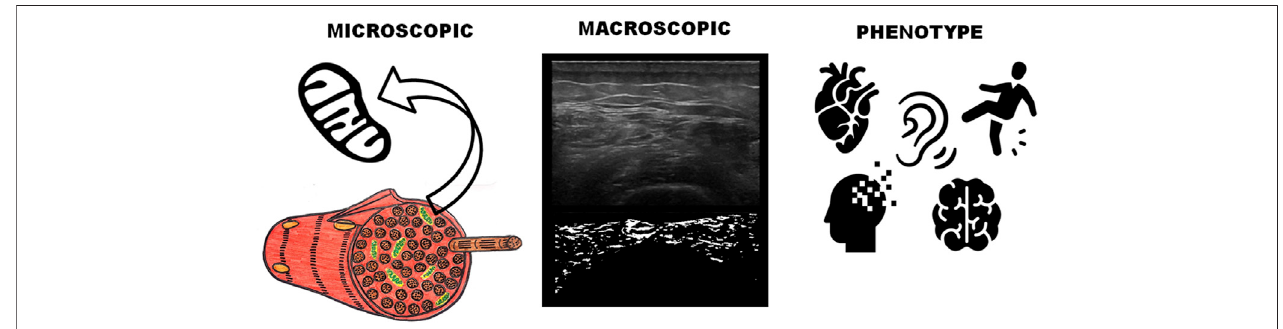
FIGURE 3 | Mitochondrial radiomic signature of ultrasound images. Radiomics aims to capture the informative content hidden in medical images, overcoming the limitations of the human eyes and human cognitive patterns. These patterns can be expressed in terms of macroscopic image-based radiomic features and carry informationabouttheirunderlyingpathophysiologicalprocessesand pinpointspeci fi cbiologicalmechanisms.Thisallowsustoinferphenotypesorsignatures,including prognosticinformation.Herewegraphicallyshowedthataradiomicphenotype,capturingthemuscleheterogeneity,wasstronglyprognosticofthedevelopmentof hearingimpairment,stroke,myocardialinfarction,dementia/memoryloss,and/orfalls.Basedonthetypeofdiseaseassociatedwiththemuscleultrasoundchanges,we alsobelievethisidenti fi edgroupofdiseasessharesamitochondriallink.Iconsutilizedinthis fi gurewereobtainfromtheNounProjectfromthefollowingauthors:Gorkem Oner (mitochondria), Gregor Cresnar (ear), Artem Kovyazin (brain), Tatina Vazest (heart), Luis Padra (fading head) and Visual Language Company (slipping